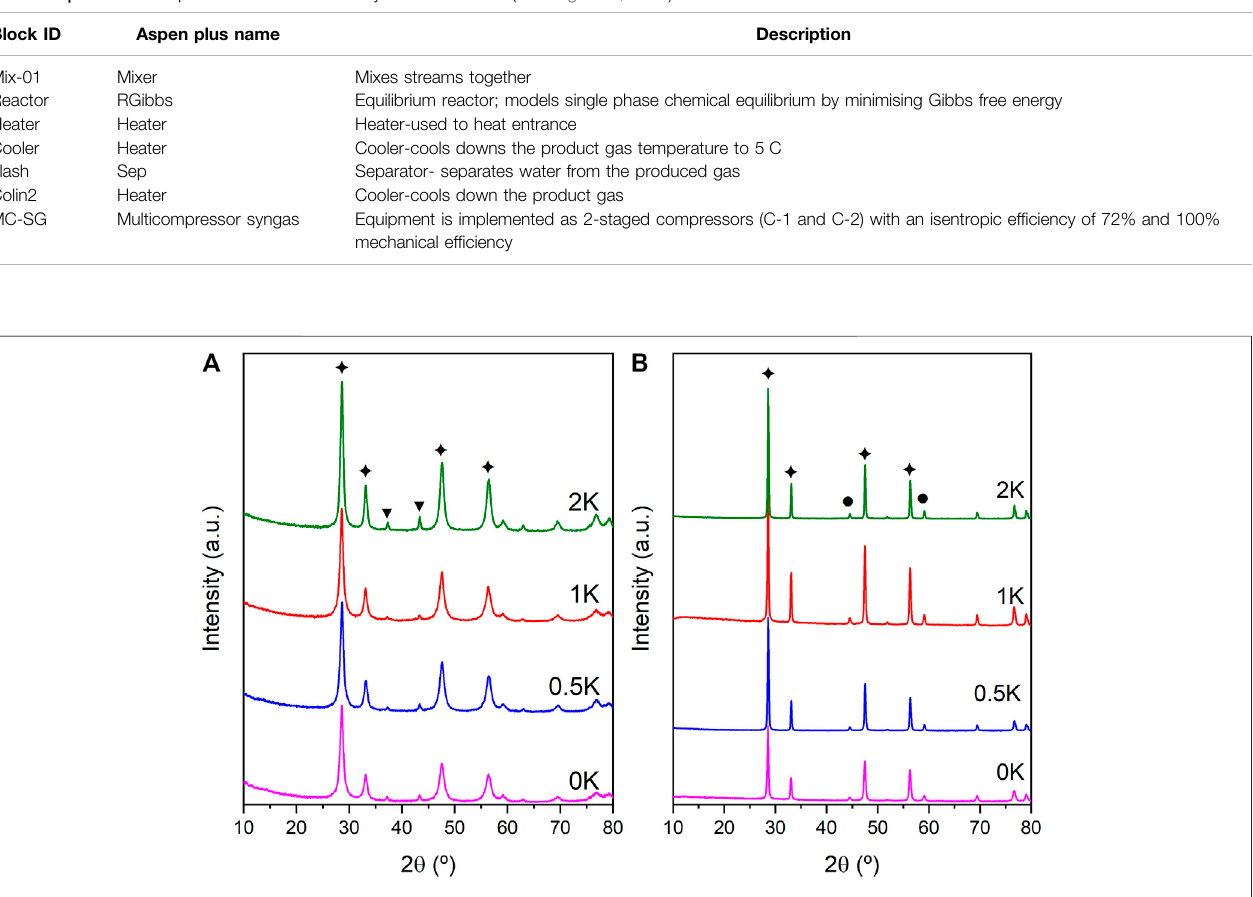
Frontiers in Chemistry |